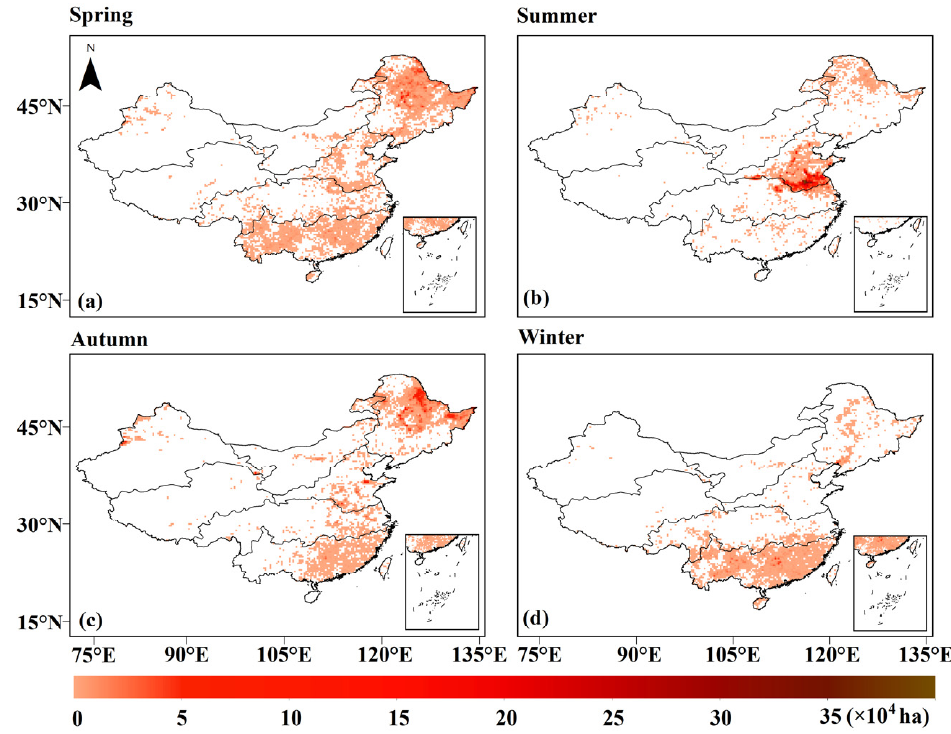
Figure 3. Spatial distribution of accumulated BA at the seasonal scale in China: ( a ) spring; ( b ) summer; ( c ) autumn and ( d ) winter.